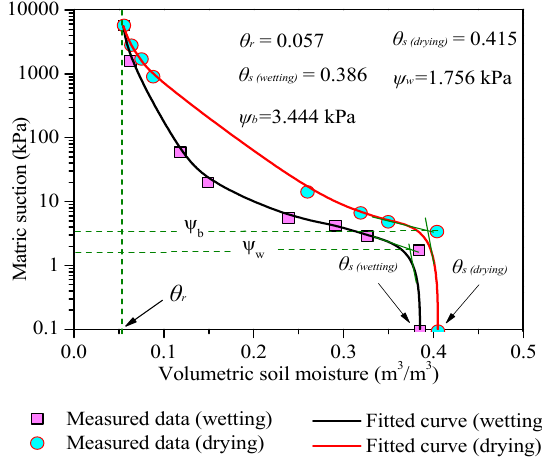
Figure 6. Soil water characteristic curves for the soil samples. θ S ( drying ) and θ S ( wetting ) are the saturated soil moistures under drying and wetting paths (m 3 /m 3 ), respectively; θ r is the residual moisture (m 3 /m 3 ); ψ b is the air entry pressure (kPa); and ψ w is the water entry pressure